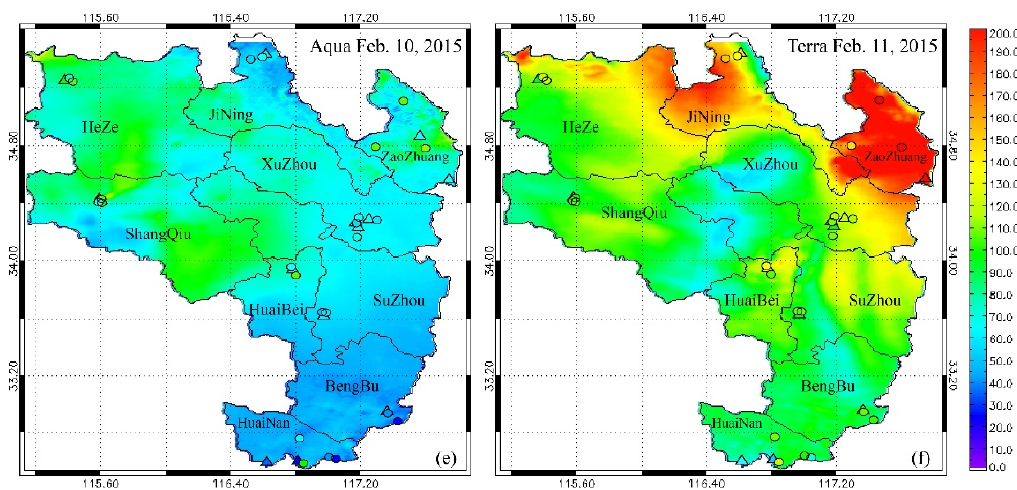
Figure 10. Spatial distribution of GTWR model-estimated PM 2.5 concentration, from Terra (local time 10:30 a.m.) and Aqua (local time 1:30 p.m.), respectively, over the study region during a haze formation process from the afternoon of 8 February 2015 to the morning of 11 February 2015 (( a ) Aqua 8 February 2015; ( b ) Terra 9 February 2015; ( c ) Aqua 9 February 2015; ( d ) Terra 10 February 2015; ( e ) Aqua 10 February 2015; and ( f ) Terra 11 February 2015). In situ measurements at training stations (circles) and validation (triangles) stations are also shown in the figures.